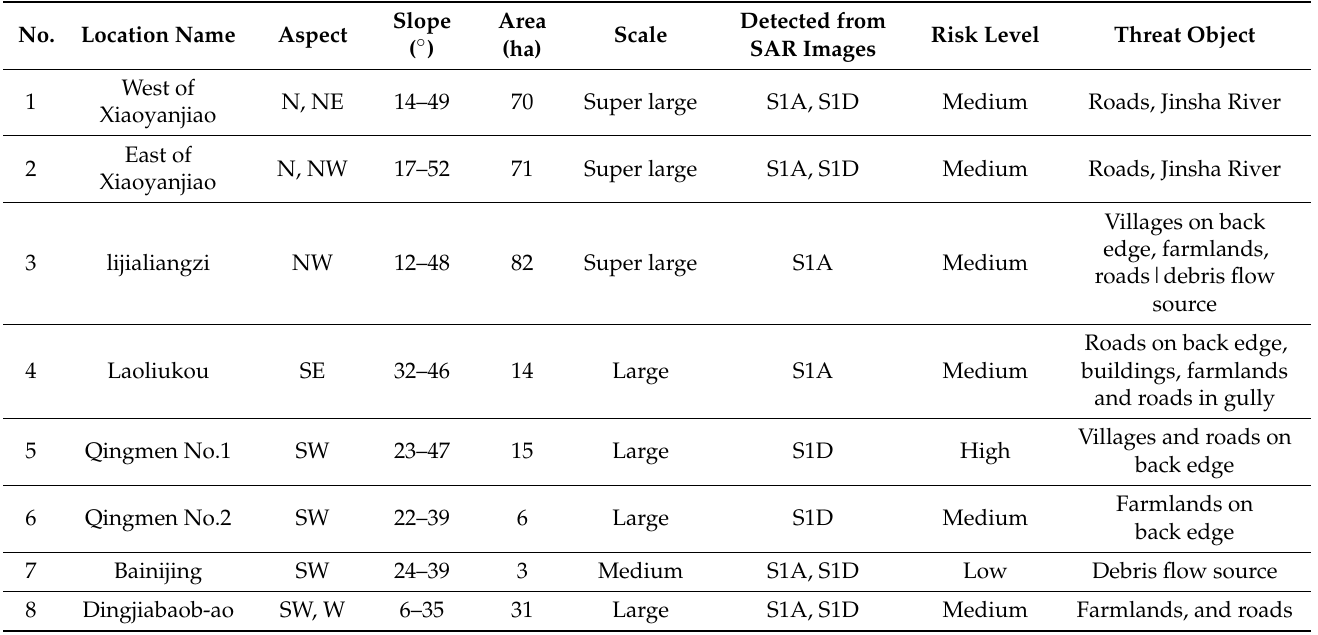
Figure 6. Accuracy assessment of LOS displacement maps. Distribution histograms of measurement scatterers in stable area are calculated based on ( a ) ascending Sentinel-1 results and ( b ) descending Sentinel-1 results. Table 4. Information of the detected active landslides 1